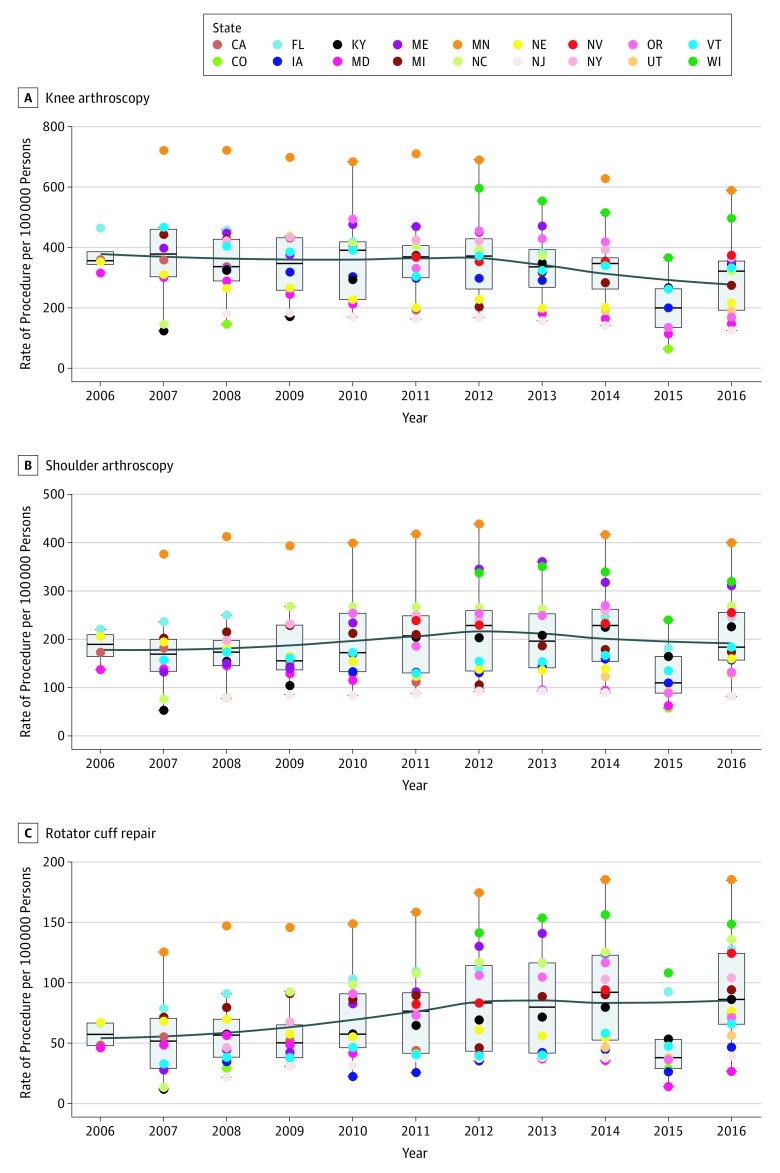
Rates of Ambulatory Knee Arthroscopy, Shoulder Arthroscopy, and Arthroscopic Rotator Cuff Repair in Select US States, 2006-2016CA indicates California; CO, Colorado; FL, Florida; IA, Iowa; KY, Kentucky; MD, Maryland; ME, Maine; MI, Michigan; MN, Minnesota; NC, North Carolina; NE, Nebraska; NJ, New Jersey; NV, Nevada; NY, New York; OR, Oregon; UT, Utah; VT, Vermont; and WI, Wisconsin.